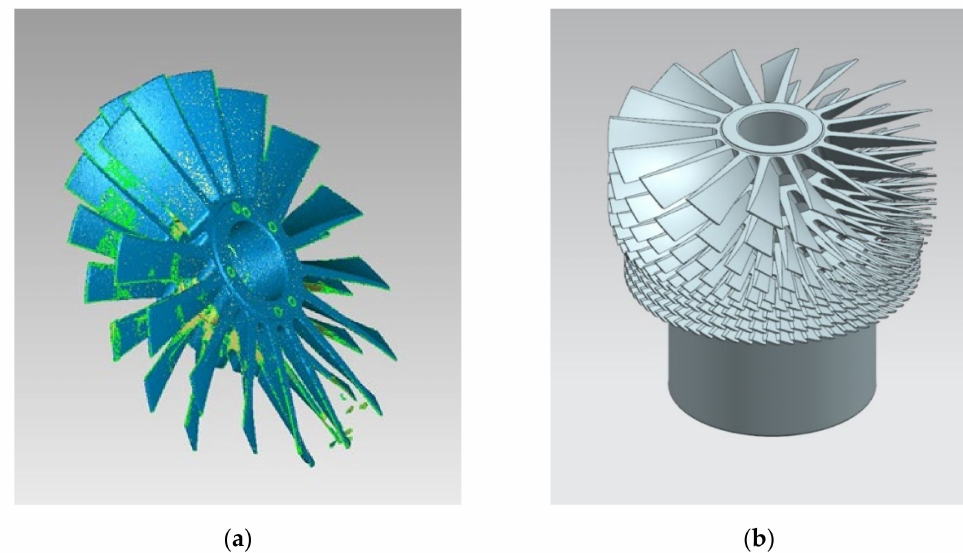
Figure 5. CAD model of rotor reconstruction. ( a ) Positioning of the first and second turbine stages; ( b ) reconstruction of the curved surface circular array and Boolean combination.